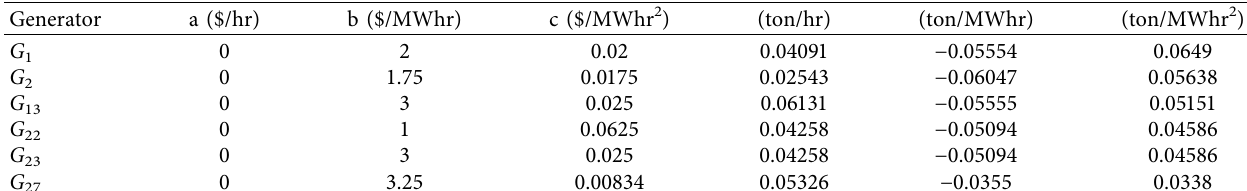
Table 19: Generation and emission coefcients for generators IEEE 30 bus-system.